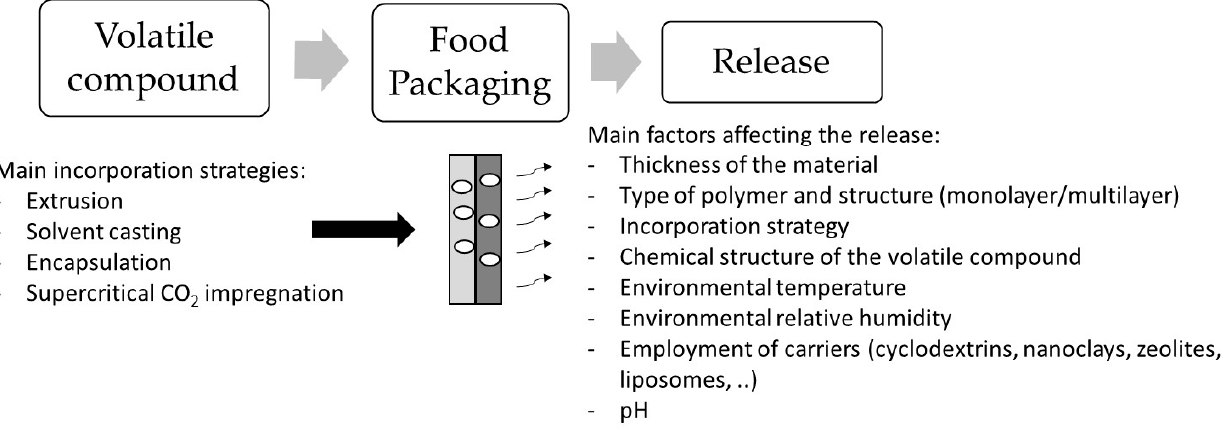
Figure 3. Scheme of the main factors affecting the release of volatile compounds from food packaging.